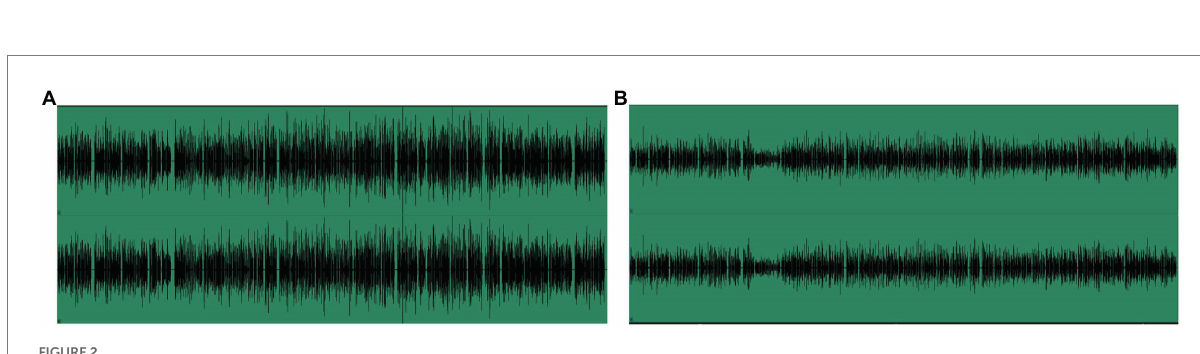
FIGURE 2 Waveforms of the two versions in the experiment. (A) The expressive version and (B) the nonexpressive